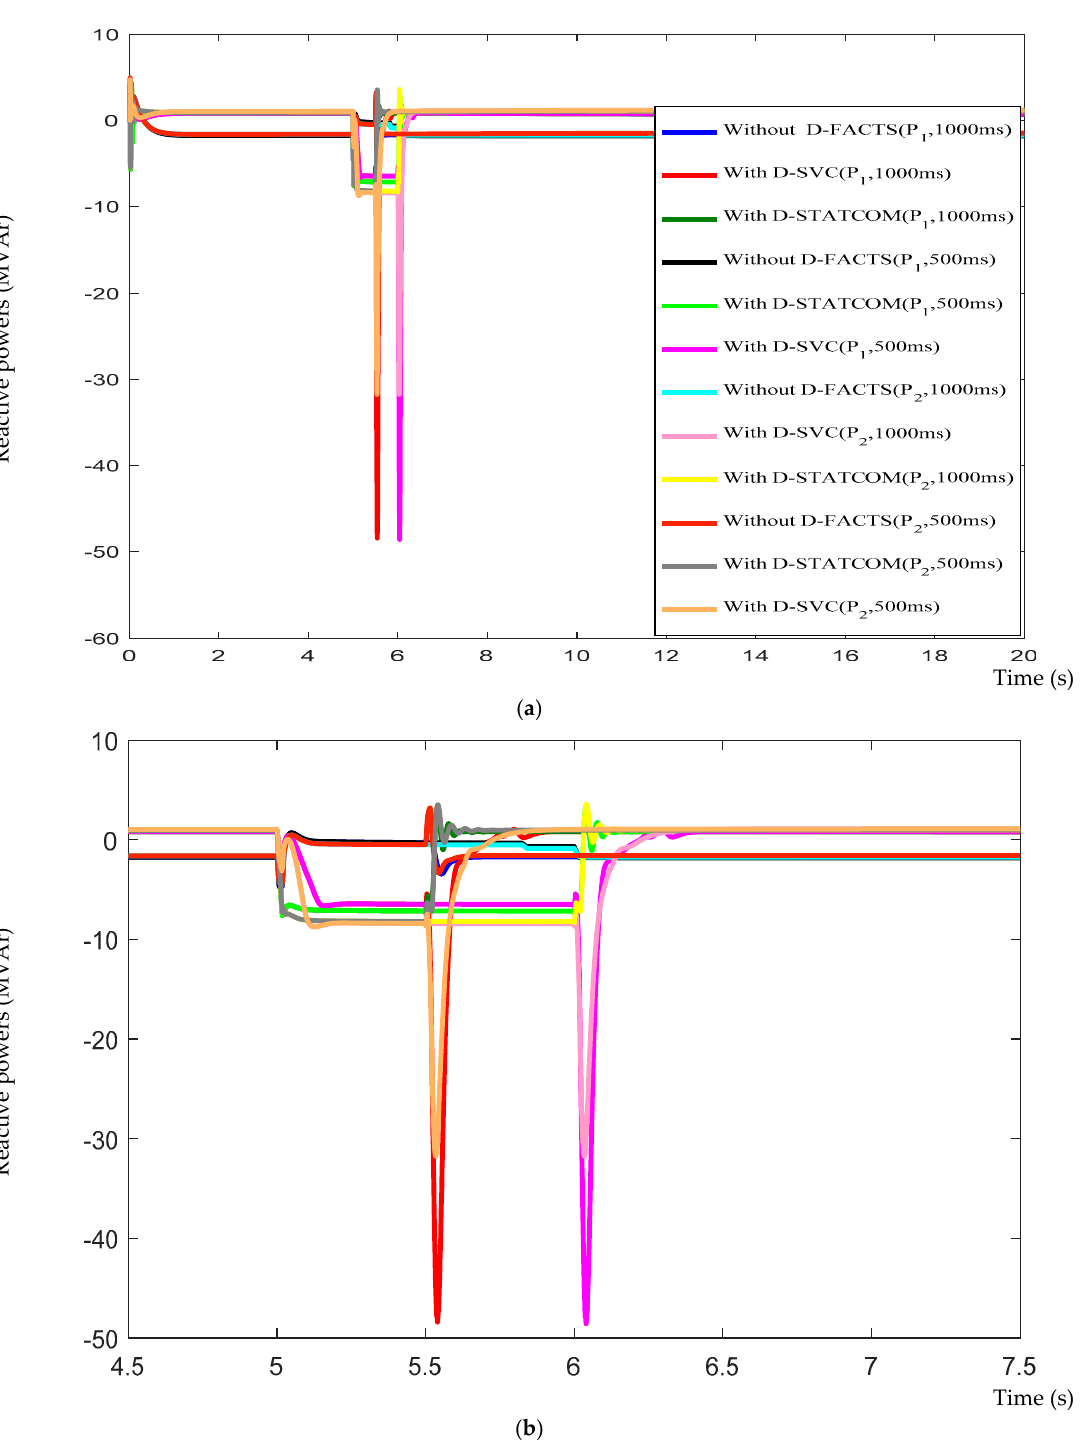
Figure 15. ( a ) Reactive power at the PCC during line-to-line electrical grid fault; ( b ) zoom of reactive power at the PCC during line-to-line electrical grid fault.